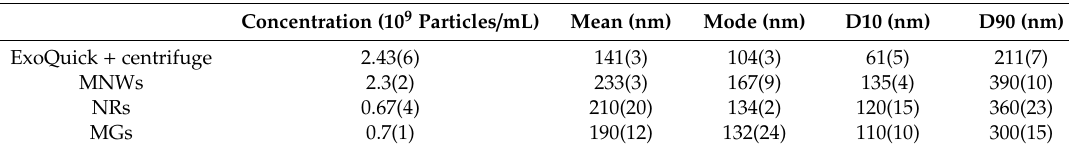
Figure 7. Size distribution (black lines) of ( a ) TEX isolated non-magnetically (using ExoQuick-TC and centrifugation) and magnetically using ( b ) MNWs, ( c ) NRs, and ( d ) MGs. In the inset, the size distribution of TEX isolated non-magnetically after feeding MNWs to the cancer cells is depicted (no magnet was employed). Error bars (in red) indicate ± 1 standard error of the mean. Table 2. Concentration, mean, mode, and diameters corresponding to 10% (D10) and (90%) cumulative undersize particle size